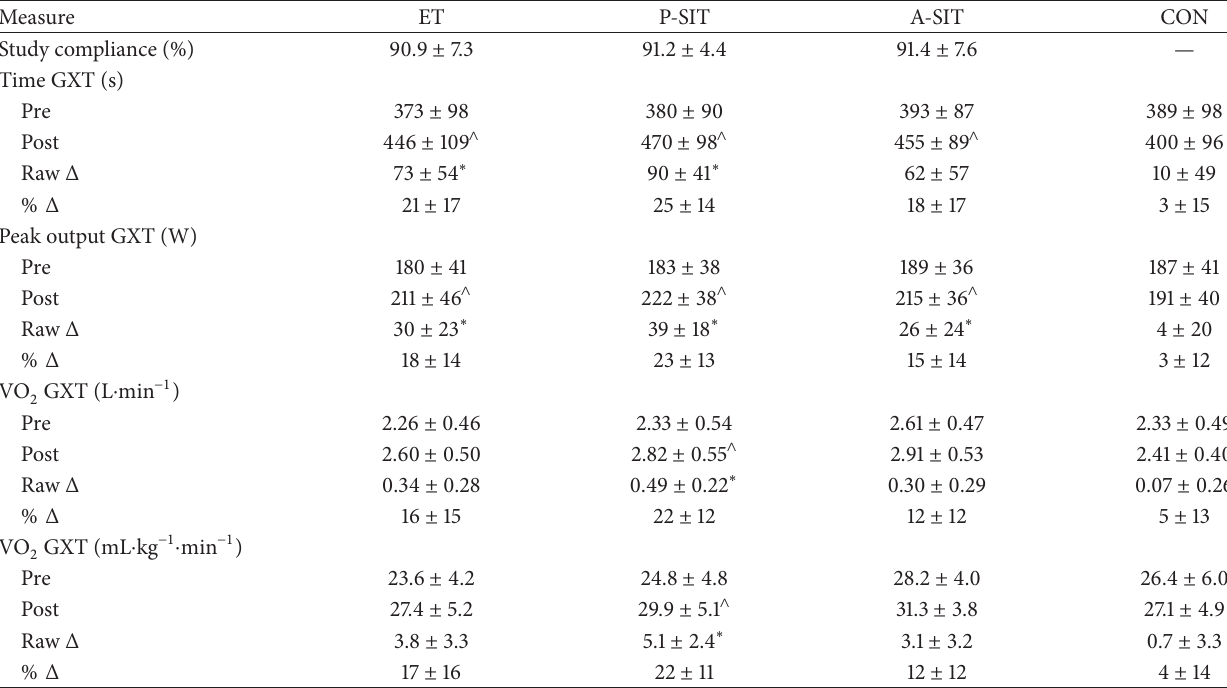
Table 2: Cardiorespiratory fitness